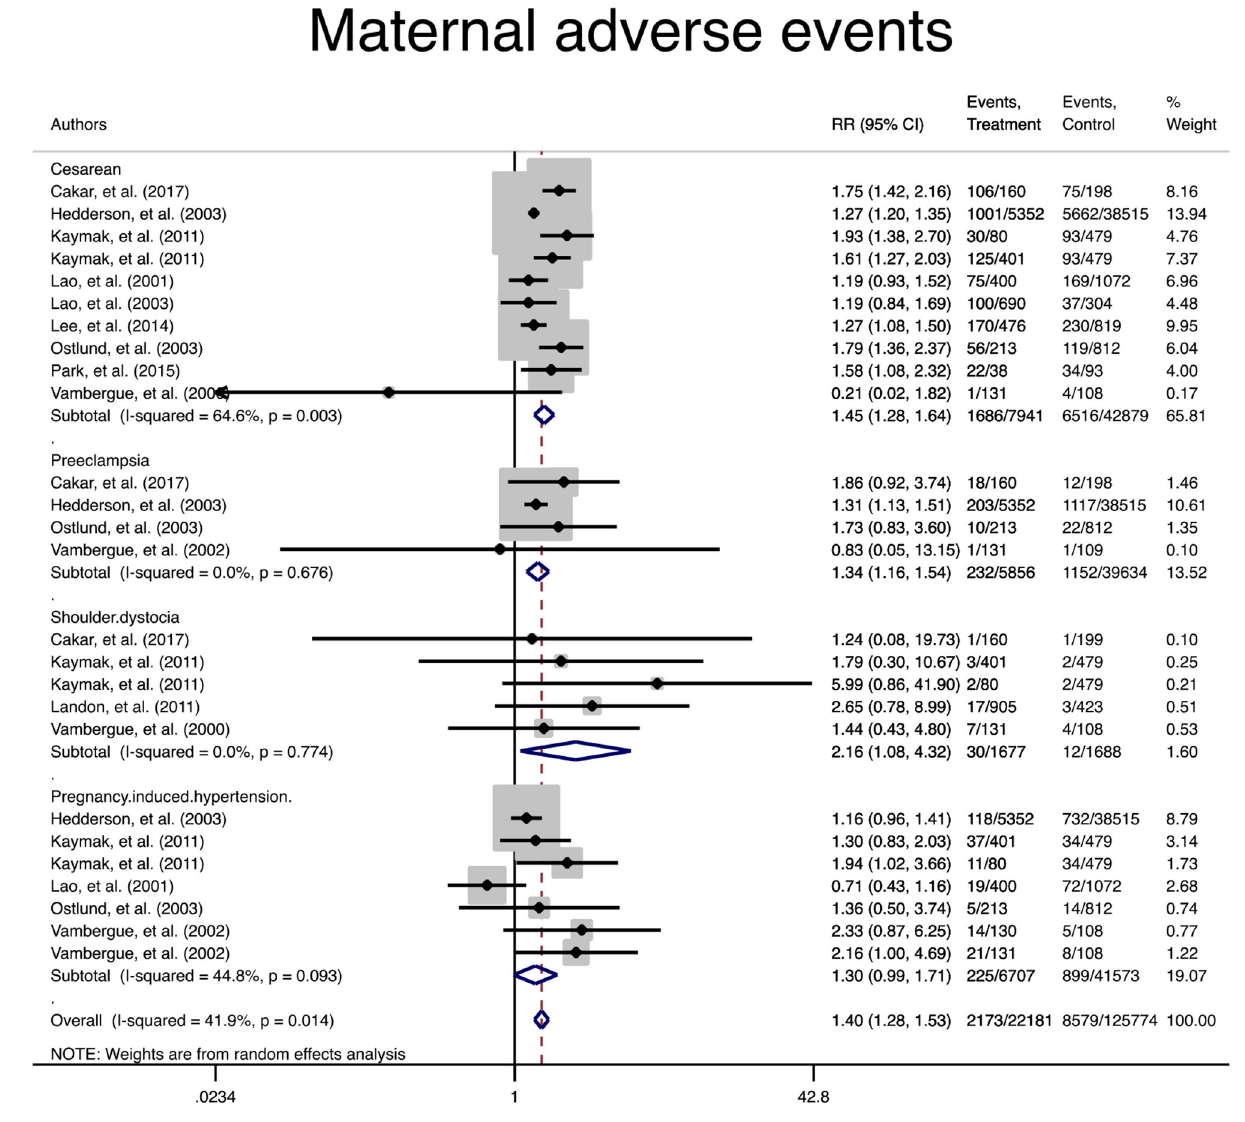
FIGURE 6 | Forest plot of pooled relative risk of adverse maternal events with the exclusion of studies that fulfilled the IADPSG (HAPO)